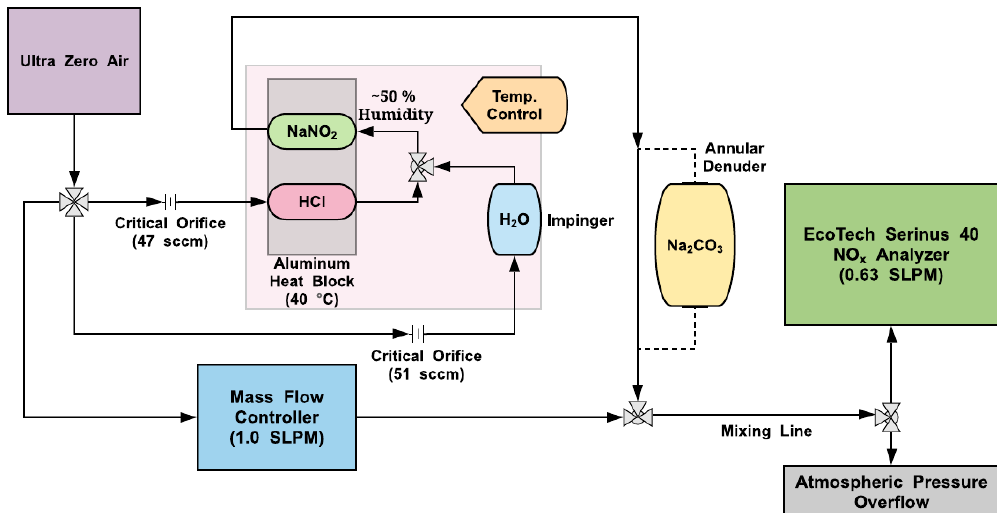
Figure 1. Flow and component schematic of the HONO calibration system (pink shaded region) interfaced with a NO x analyzer (green), dilution mass flow controller (blue), and an exchangeable Na 2 CO 3 annular denuder (yellow). Lines with black arrows denote the direction of gas flow through system components. Tee and cross fittings are denoted by arrays of grey